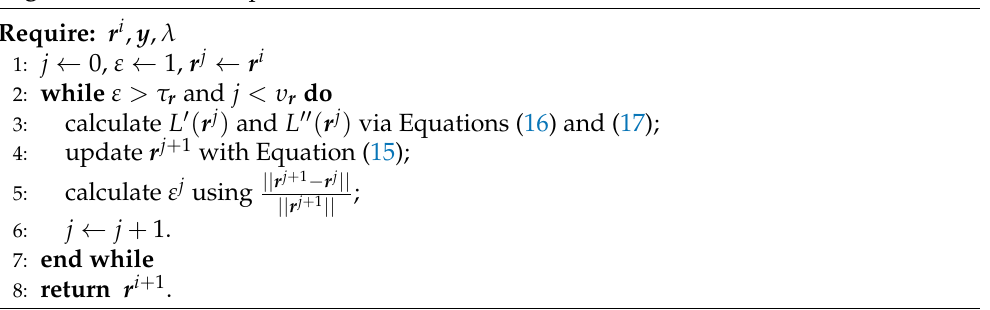
Algorithm 1 Solve Subproblem of r with the Newton